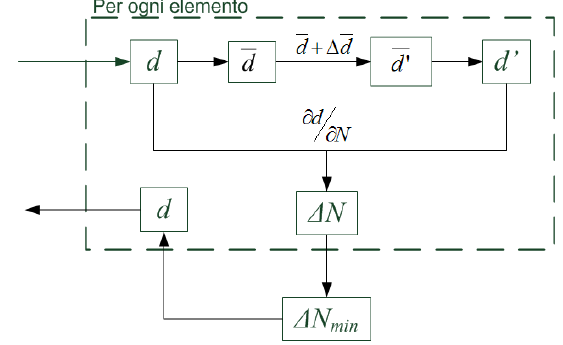
Figura 5: Schema di funzionamento della subroutine.